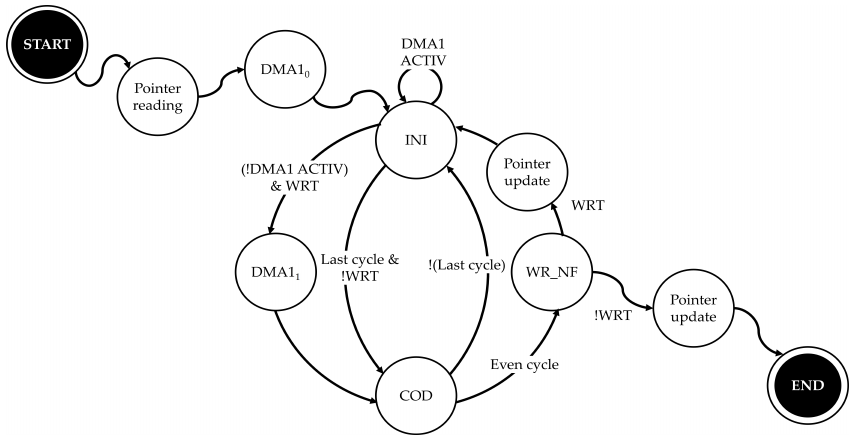
Figure 11. Finite state machine of writing in NAND Flash for writing. For the encoding and writing process of the NAND flash chip it is necessary to activate the DMA process. Note that the pointer reading process must be done before writing begins. At the end of writing, the pointer address always needs to be